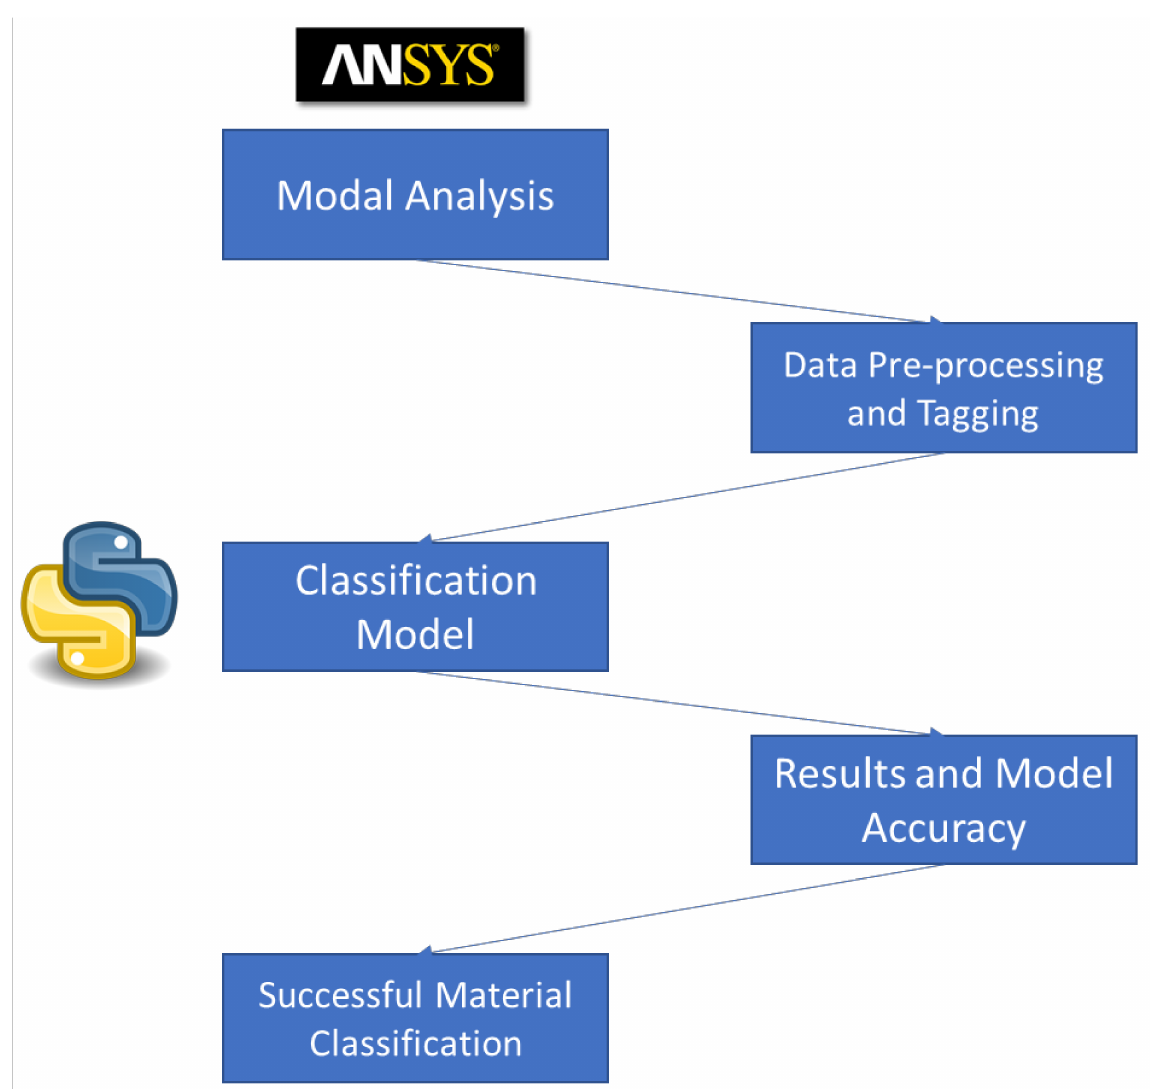
Figure 13. Overall summary and procedure of using ML and DL in engineering materials